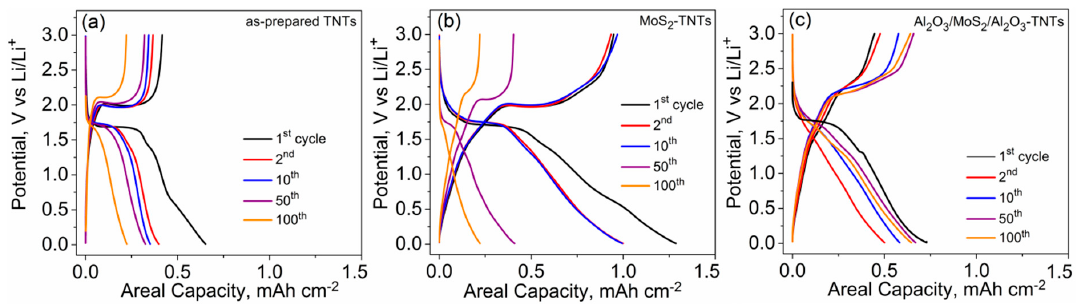
Figure 4. Galvanostatic charge / discharge profiles of ( a ) as-prepared TNTs, ( b ) MoS 2 -TNTs, and ( c ) Al 2 O 3 /MoS 2 /Al 2 O 3 -TNTs at 1C.